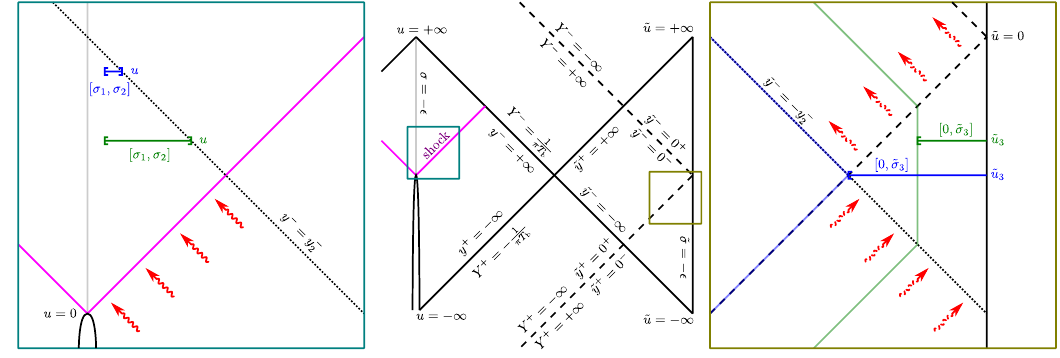
Figure 5 . The bath and purifier subsystems. The central panel shows a Penrose diagram of various coordinate patches of the bath and purifier subsystems. The left panel shows two examples, sharing the same y − , of an interval [ σ 1 , σ 2 ] of the bath system after the Page time: the shorter 2 blue interval is just barely above the critical length ∆ turn needed to recover the black hole interior; the green interval is much longer. Red wavy lines show thermal radiation leaving the bath prior to y − = y − . The right panel shows the corresponding intervals [0 , ˜ σ 3 ] needed in conjunction with 2 the bath intervals (plus QM ) to recover the black hole interior. The phase boundaries of ˜ σ 3 for L recoverability is shown in light blue and green. The dashed wavy lines show the thermal quanta of the purifier that are most entangled with the radiation marked in the left